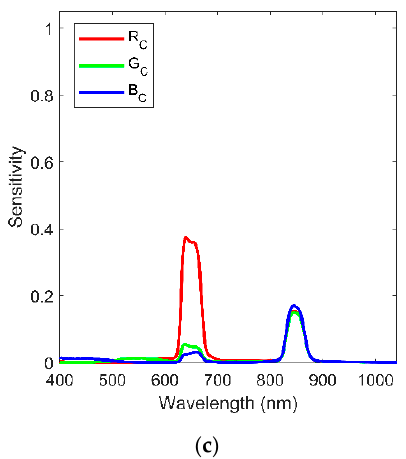
Figure 1. Channel sensitivities of ( a ) Pi camera and long-pass filter, two-band-pass filter, ( b ) Ncam lp, and ( c ) Ncam